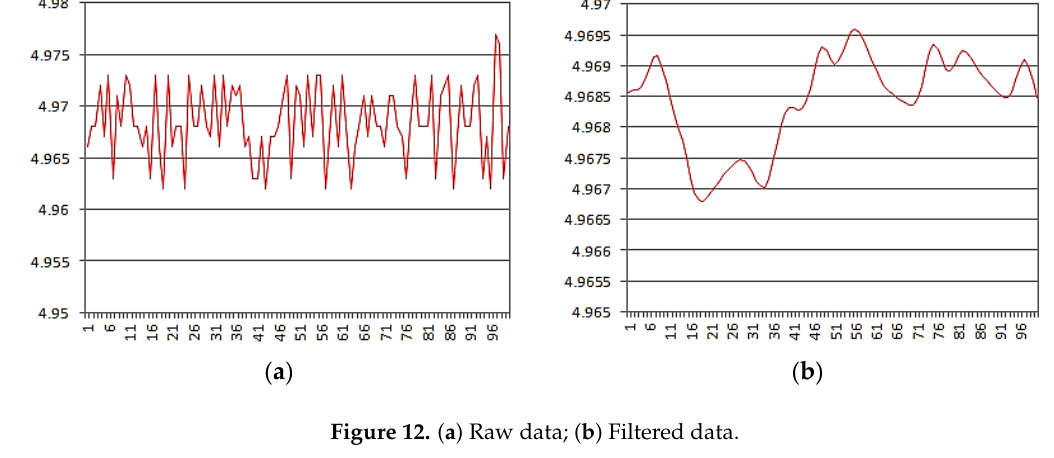
Table 3. Experiment data of inner diameter measurement (mm).